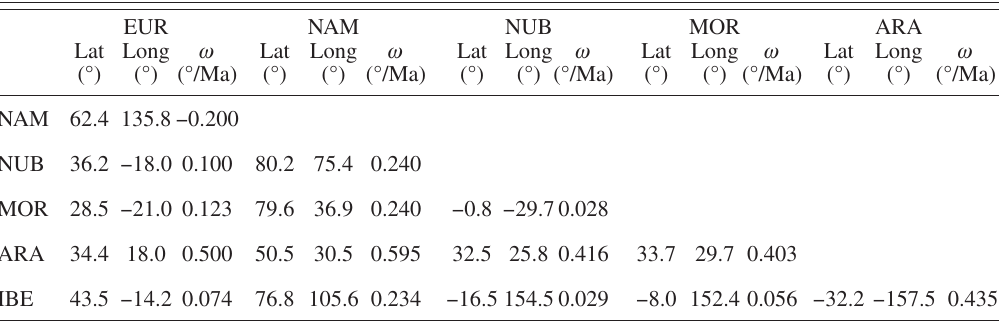
Table I. Relative Euler poles (latitude, longitude and angular velocity) of the plates shown in fig. 4, obtained by inverting the kinematic indicators reported in table IIa-i. ARA = Arabia; EUR = Eurasia; IBE = Iberia; MOR = = Morocco; NAM = North America; NUB = Nubia. See text for